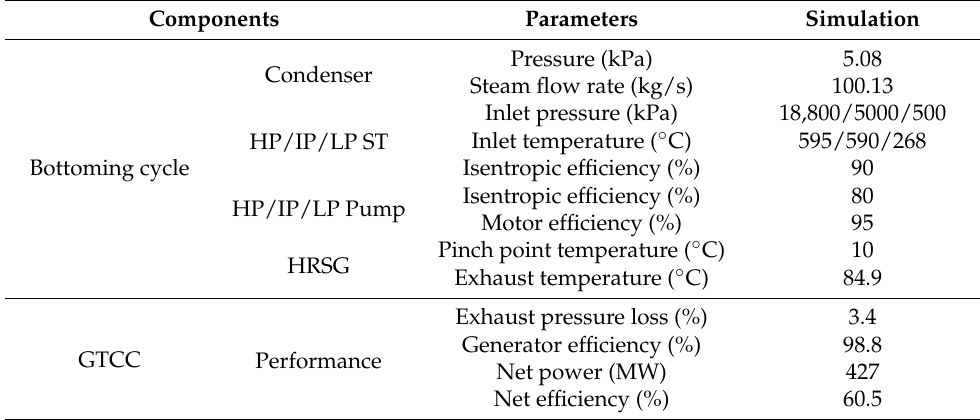
Table 3. Bottoming cycle design parameters and GTCC